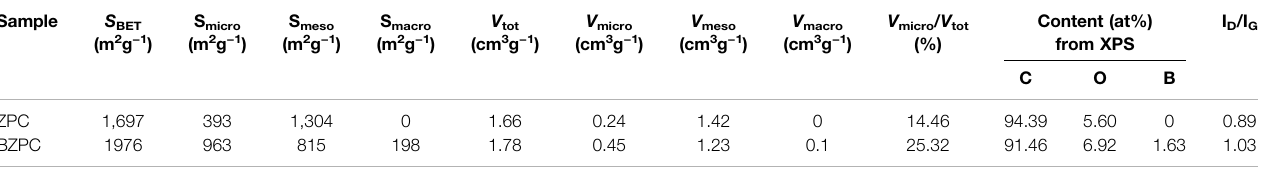
TABLE 1 | Basic physical-chemical properties of ZPC and BZPC.